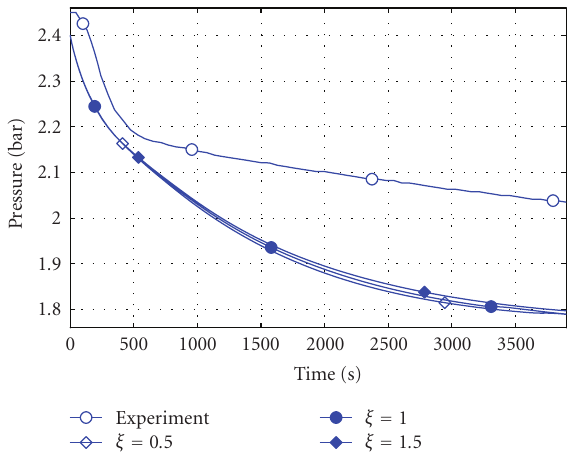
Figure 8: Pressure evolutions with di ff erent loss coe ffi cients.